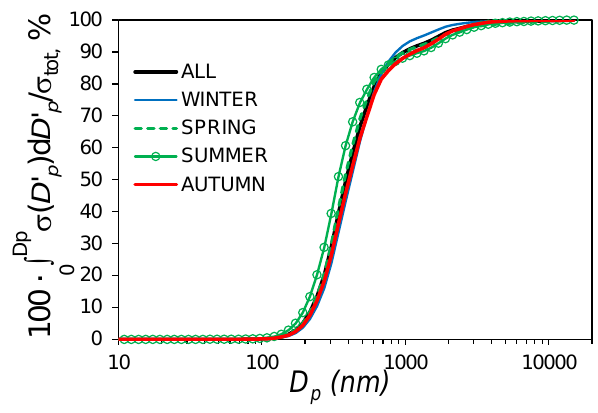
Fig. 11. Cumulative and normalized modelled σ SP at λ = 550nm in all data and in four